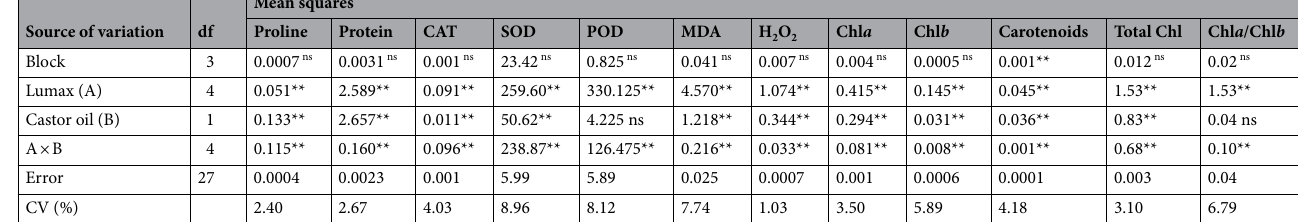
Table 1. Analyses of variance of the data for proline, soluble protein, antioxidant enzymes activities (CAT, SOD, and POD), malondialdehyde (MDA), H 2 O 2 , photosynthetic pigments (Chl a , Chl b , and Carotenoids), total chlorophyll (Total Chl) and chlorophyll a / b ratio of Solanum nigrum in response to different doses of Lumax with and without Castor oil application. ns,*,**: No significant and significant at P ≤ 0.05 and P ≤ 0.01, respectively. CAT: catalase, SOD: superoxide dismutase, POD: peroxidase.